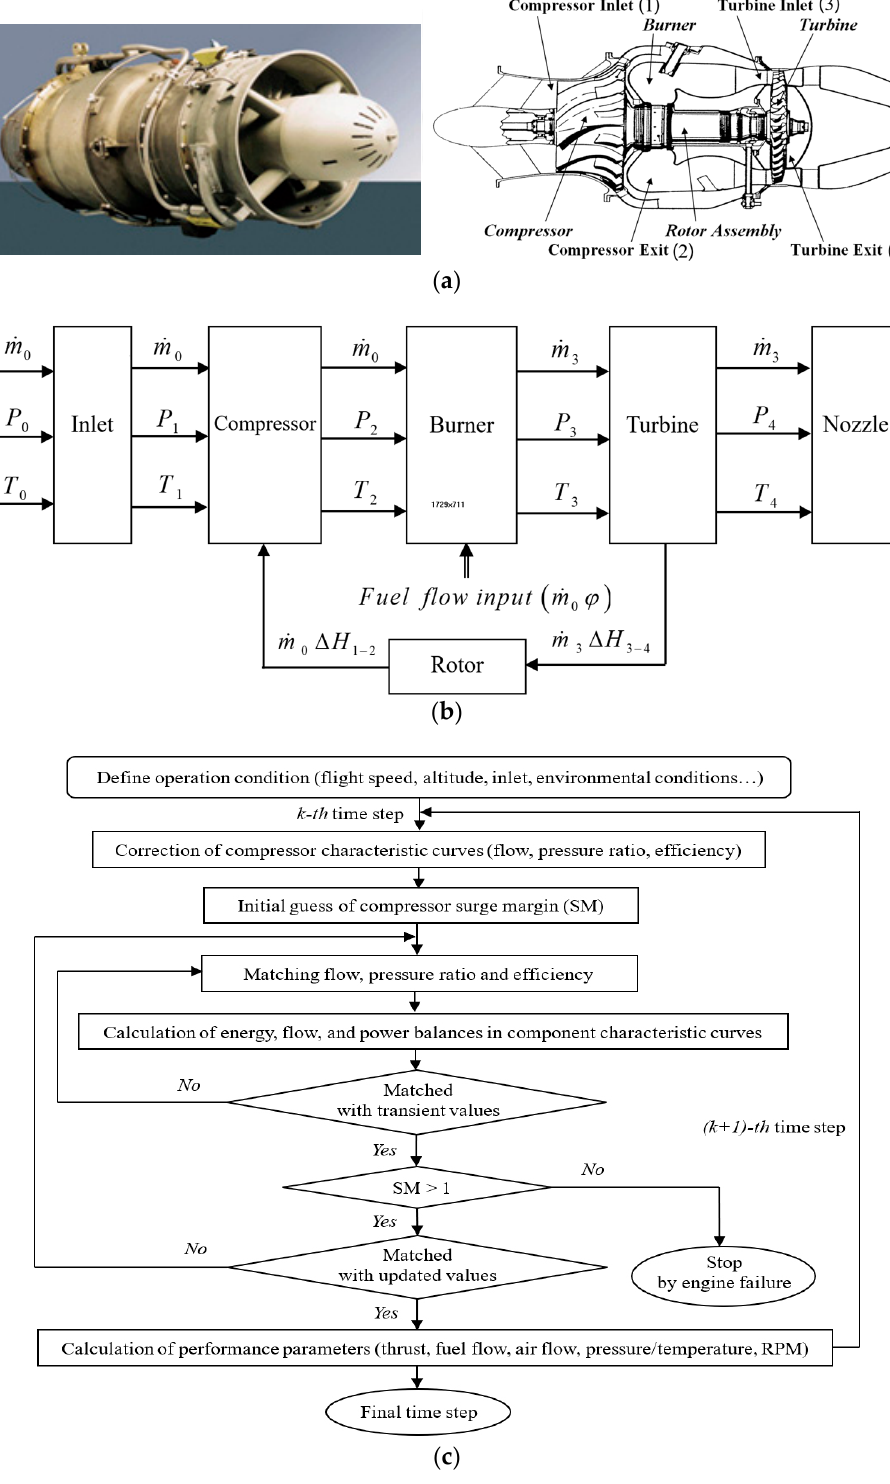
Figure 1. Schematic of the turbojet engine cycle analysis: ( a ) engine configuration; ( b ) process of gas path analysis (GPA) with component level model (CLM); ( c ) process of overall cycle analysis.